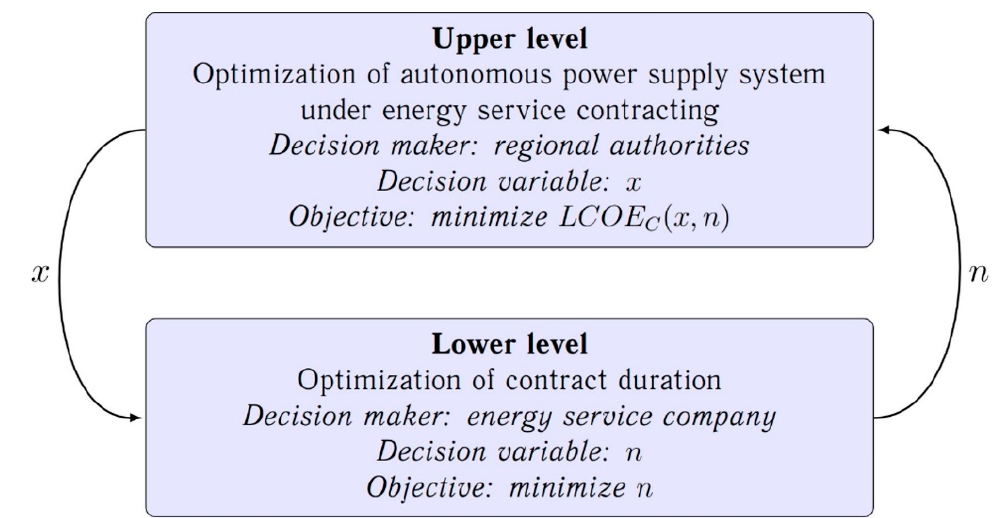
Figure 2. Chart of the hierarchical model.